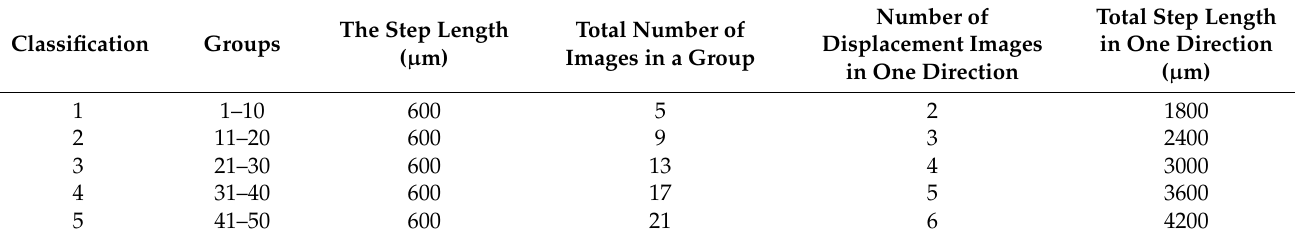
Table 4. Classification of the experiments.